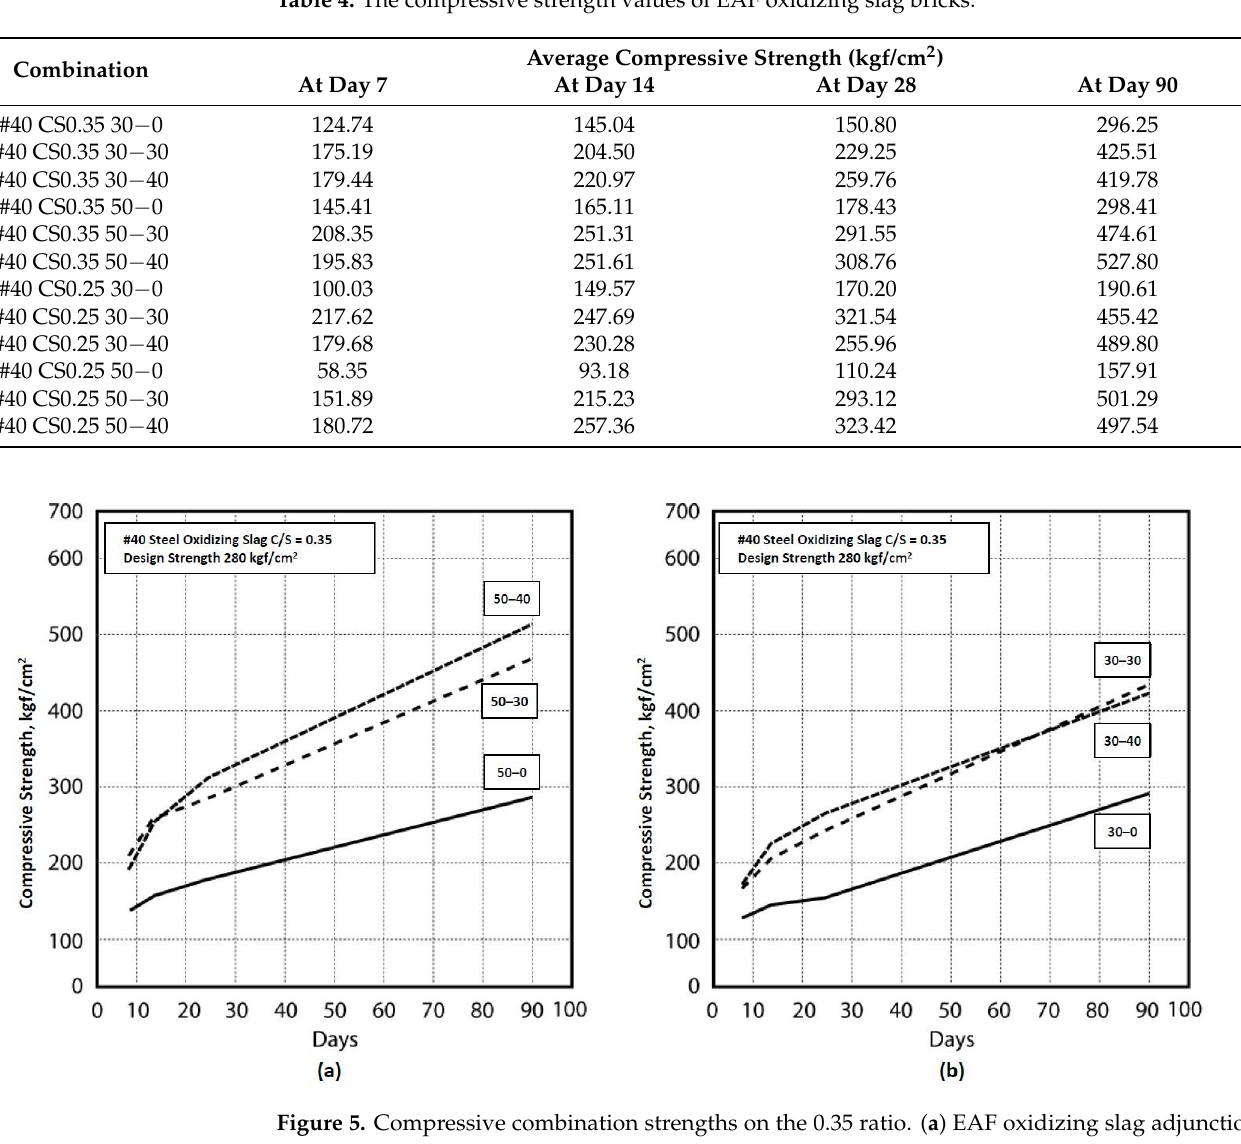
Table 4. The compressive strength values of EAF oxidizing slag bricks.